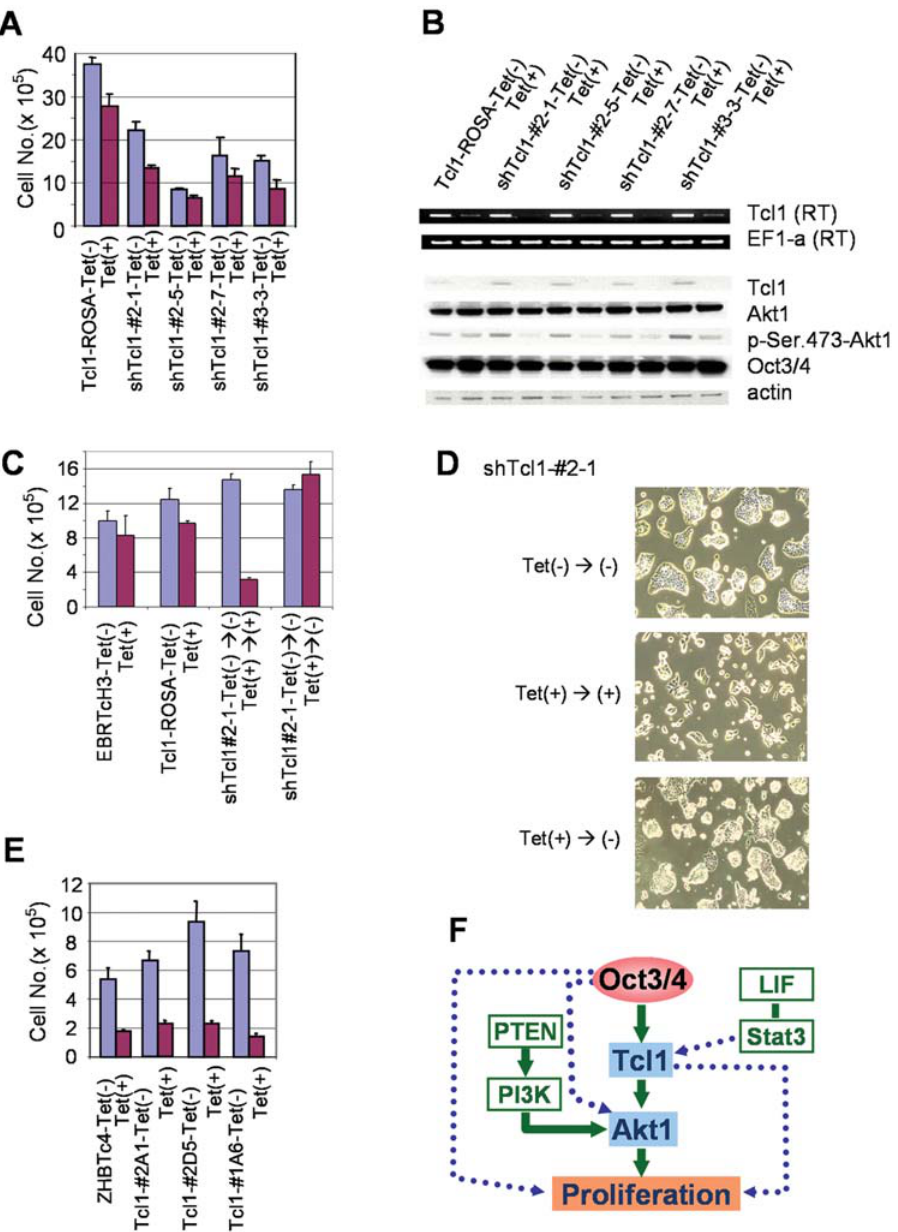
Figure 6. Functional analysis of Tcl1 in ES cells . (A) Expression level of Tcl1 gene effects on cell proliferation. The number of ES cells decreased when Tcl1 was knocked down by shRNA. (B) RT-PCR and Western blot analysis of ES cells with shRNA of Tcl1 gene. Tcl1 gene expression affected active Akt1 (p-Ser.473 Akt1), but not wild type of Akt1. (C) Reversibility of Tcl1 downregulation effect. The number of cells was rescued in the absence of Tet. (D) Photomicrographs of ES cell cultures. The number of ES cells decreased when Tcl1 was knocked down by shRNA. Cell proliferation was rescued in the absence of Tet. (E) Overexpression of Tcl1 does not rescue cell proliferation while Oct3/4 is repressed. (F) A model for the involvement of Oct3/4-Tcl1- Akt in ES cell